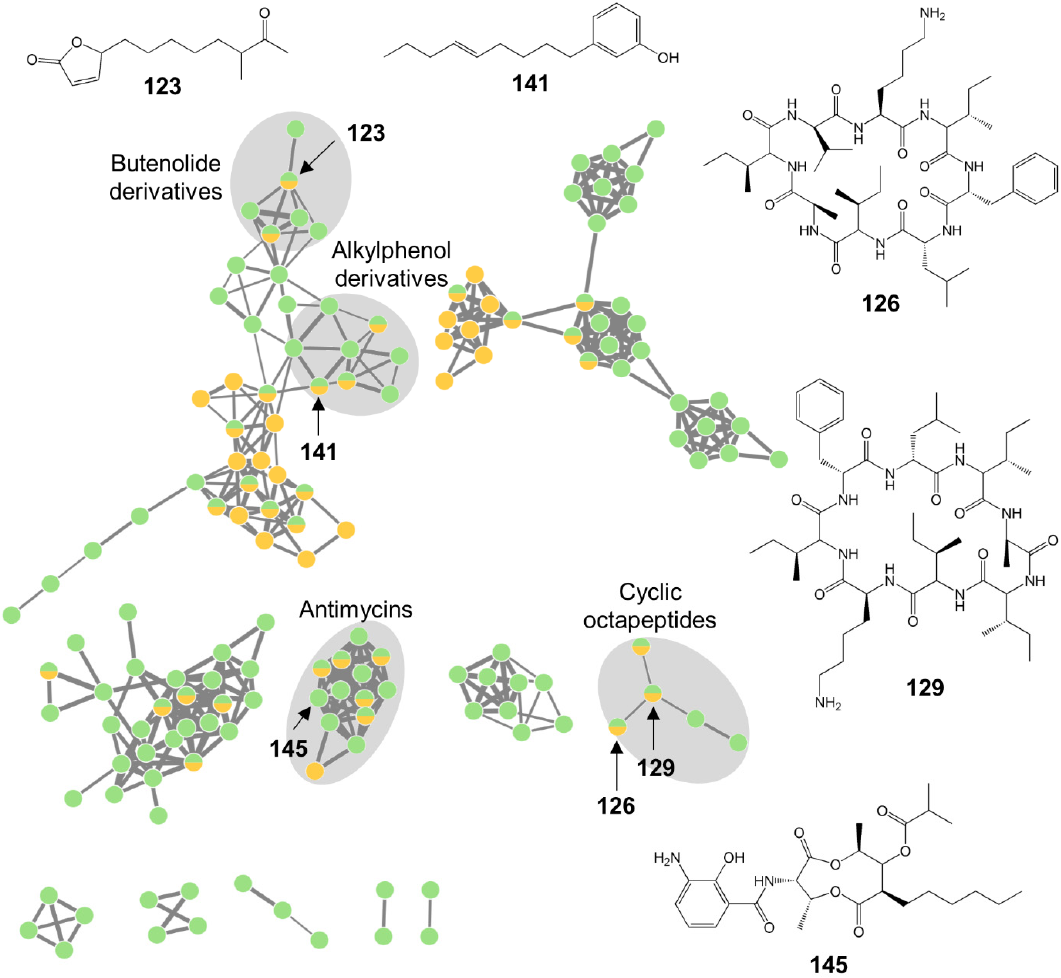
Figure 7. The global metabolome of Streptomyces sp. strain CKT43. The annotated global FBMN was constructed in GNPS with pre-processed MS / MS data. Single nodes are not displayed and the width of edges corresponds to the respective cosine score. Putatively annotated clusters are highlighted in grey and putatively identified compounds are annotated in the MN (for identification see Table S10). Nodes are color-coded by the respective cultivation medium: yellow = GYM, green = MB.